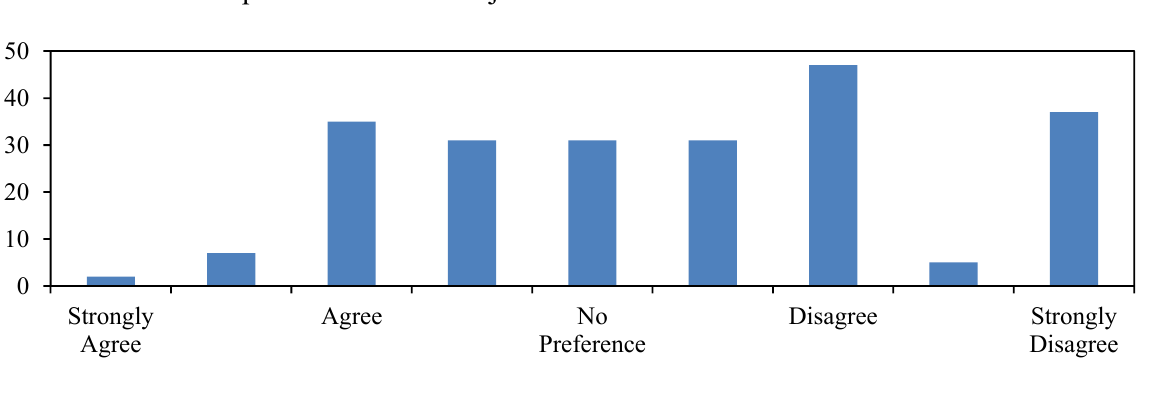
Figure 13. Graph of responses to the statement “I would trust a computer to evaluate what data is relevant to particular science